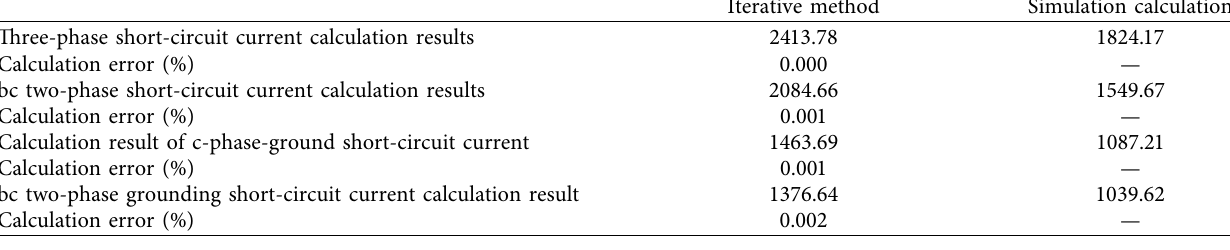
Iterative method